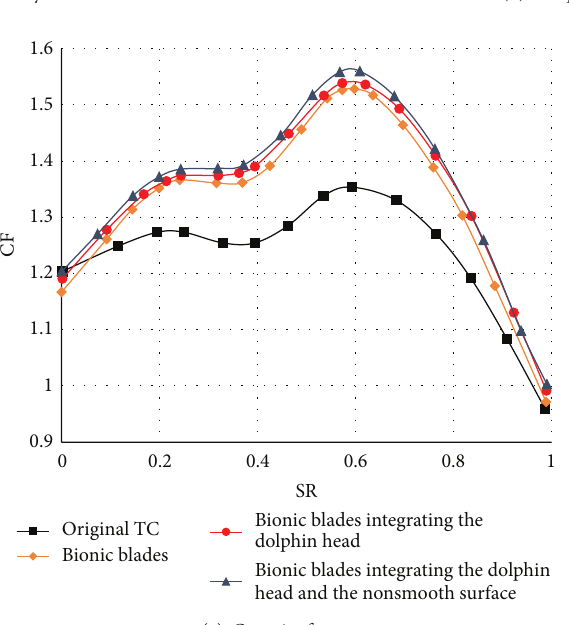
Figure 17: Performance prediction of three coupling